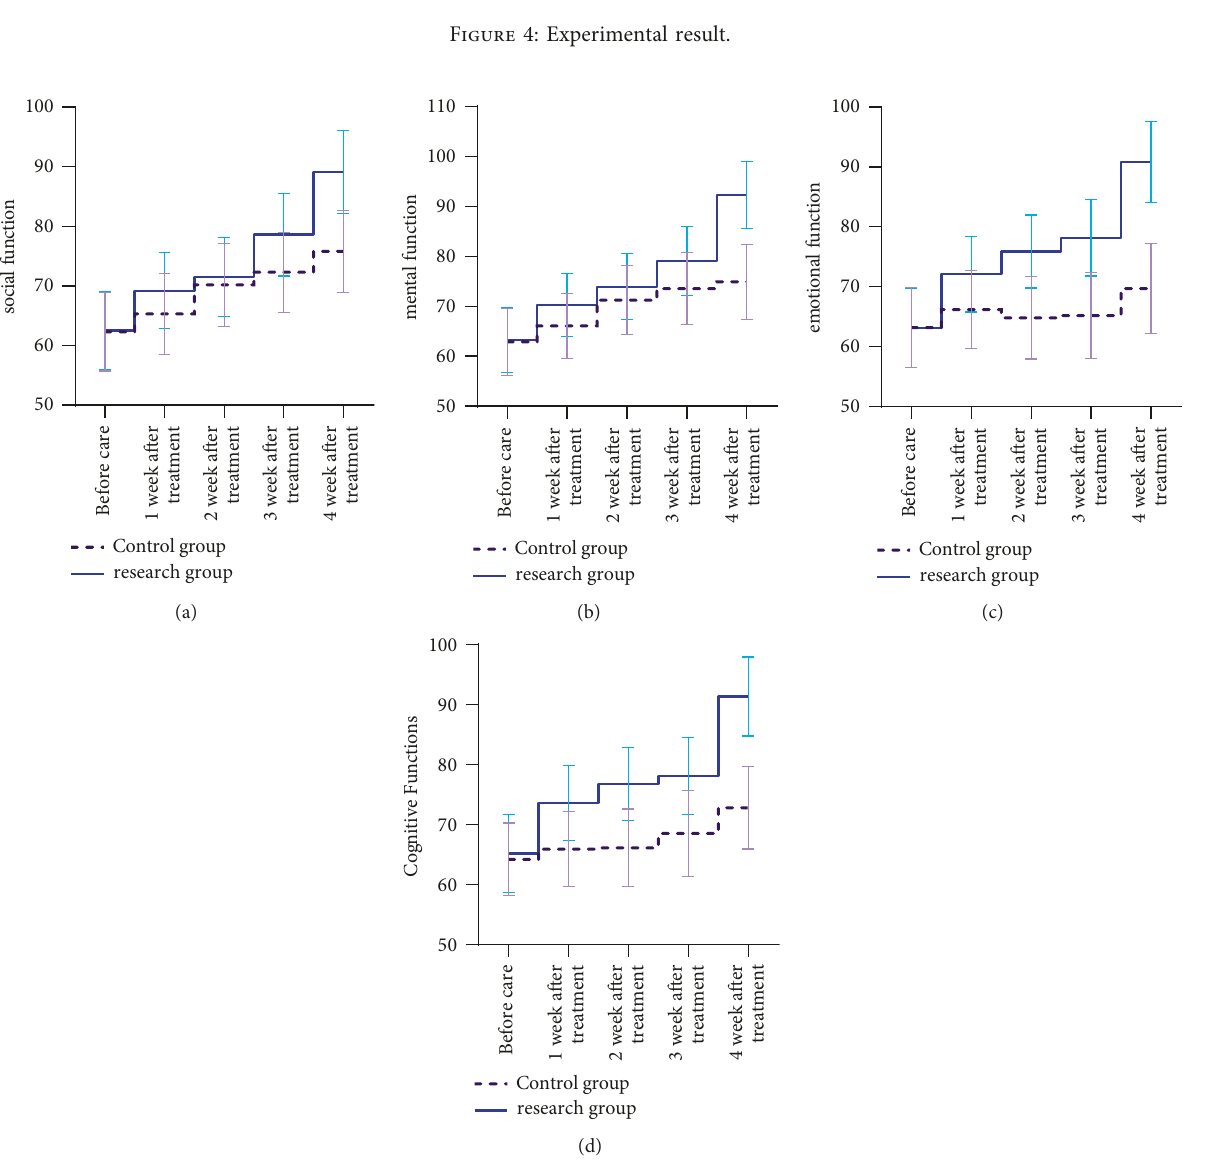
Figure 4: Experimental result.